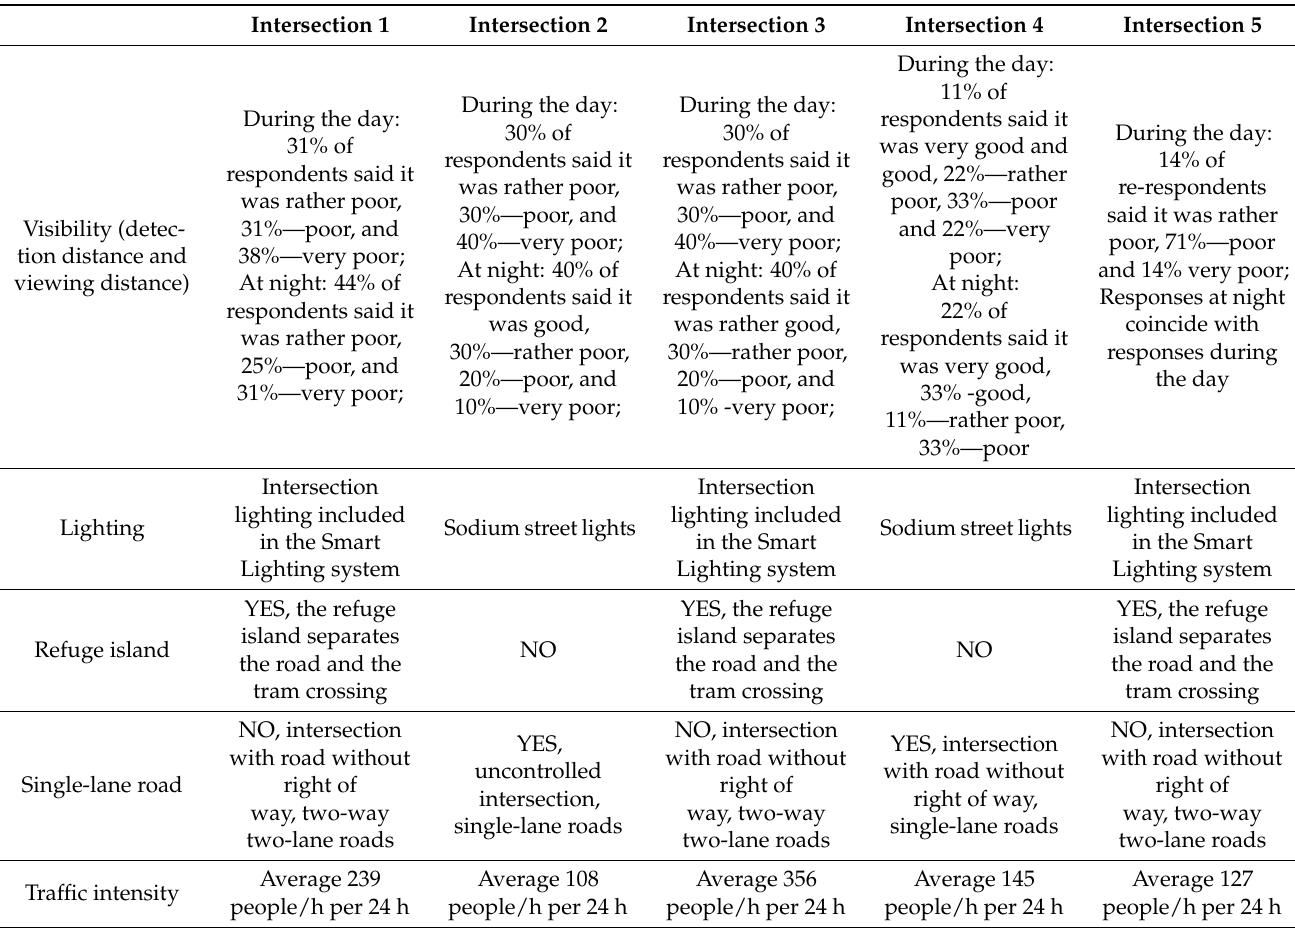
Table 2. Five star details by